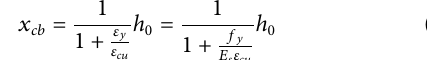
FIGURE3| Straindistribution